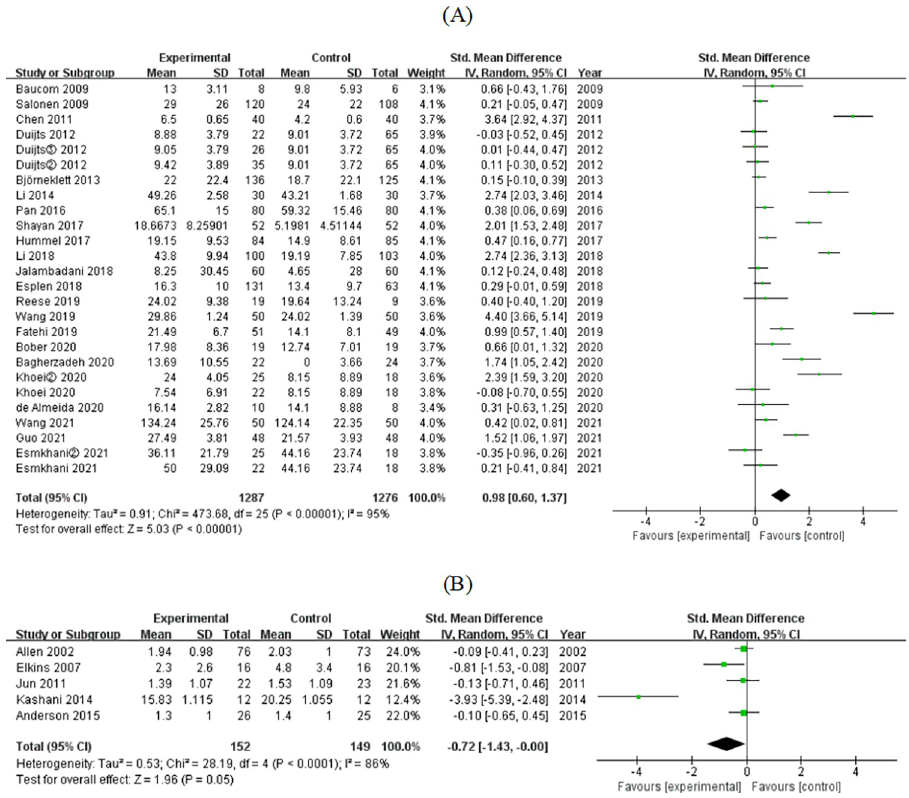
Fig 4. Forest plot of effect of nursing interventions on sexual function in studies with (A) high-priority scale; (B) low- priority scale.